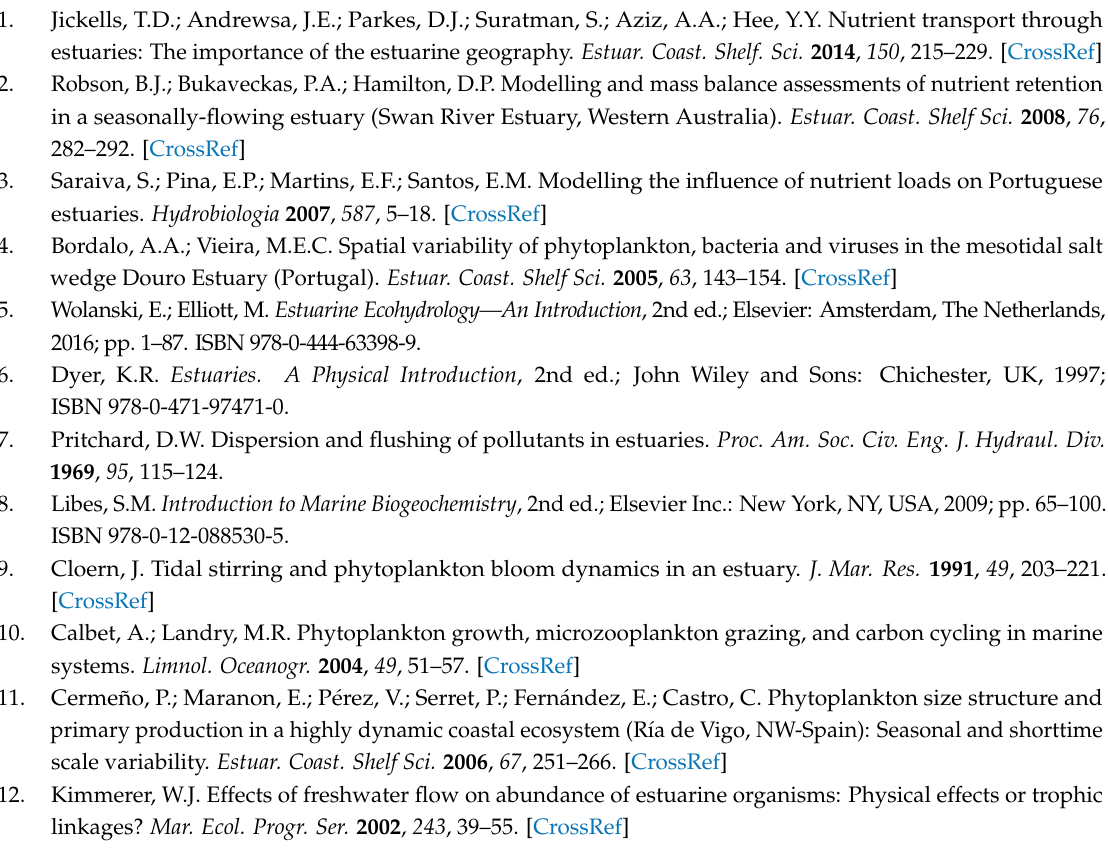
Figure S1: Longitudinal profiles of temperature and total suspended solids in the temperate Lima estuary, Table S1: Mean concentrations ± SE for key environmental parameters measured at the surface of the sampling sites: Secchi disc (SD)—m (in bold-bottom depth); temperature— ◦ C; salinity; dissolved oxygen (DO)—mg O 2 L − 1 ; pH; NO 3 − , NO 2 − , NH 4+ , PO 43 − , N:P, and Si— µ M; chlorophyll a (CHL a )—mg m − 3 ; total cell counts (TCC)—log 10 cells mL − 1 . In brackets—minimum and maximum values, Table S2: Mean concentrations ± SE for key environmental parameters measured at middle depth of the sampling sites: temperature— ◦ C; salinity; dissolved oxygen (DO)—mg O 2 L − 1 ; pH; NO 3 − , NO 2 − , NH 4+ , PO 43 − , N:P, and Si— µ M; chlorophyll a (CHL a )—mg m − 3 ; total cell counts (TCC)—log 10 cells mL − 1 . In brackets—minimum and maximum values, Table S3: Mean concentrations ± SE for key environmental parameters measured near bottom of the sampling sites: temperature— ◦ C; salinity; dissolved oxygen (DO)—mg O 2 L − 1 ; pH; NO 3 − , NO 2 − , NH 4+ , PO 43 − , N:P, and Si— µ M; chlorophyll a (CHL a )—mg m − 3 ; total cell counts (TCC)—log 10 cells mL − 1 . In brackets—minimum and maximum